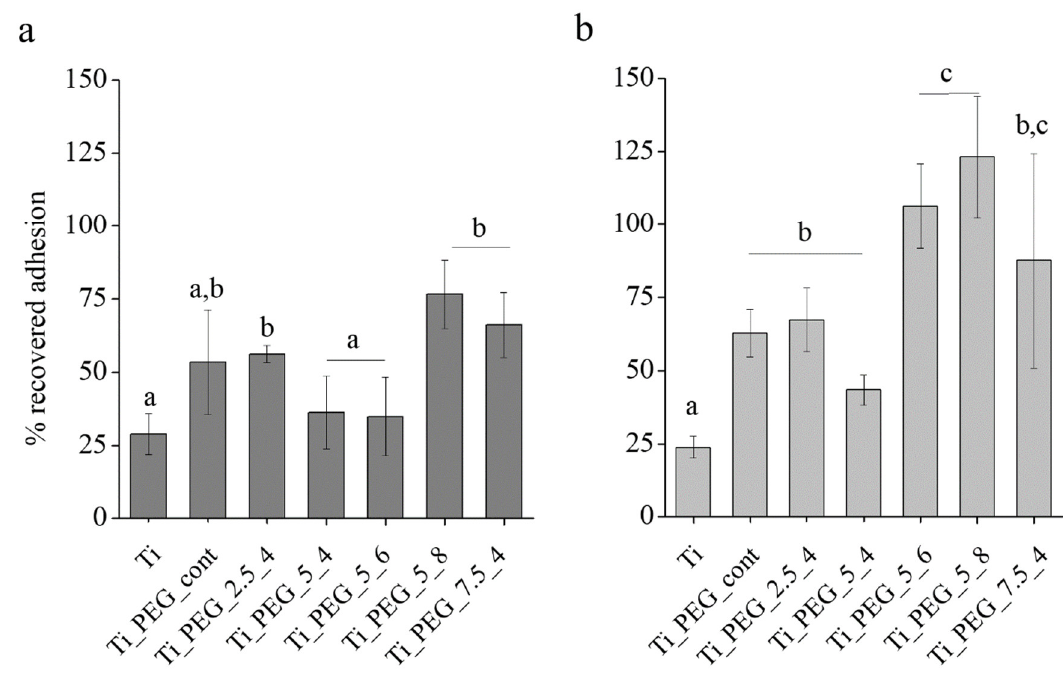
Figure 9. % of area covered by human foreskin fibroblasts (hFFs) in the presence of S. aureus ( a ) and E. coli ( b ), respect the area covered by cells in the sample of the same condition without bacteria. In each graph, conditions with the same letter present no statistically significant differences ( p < 0.05) .